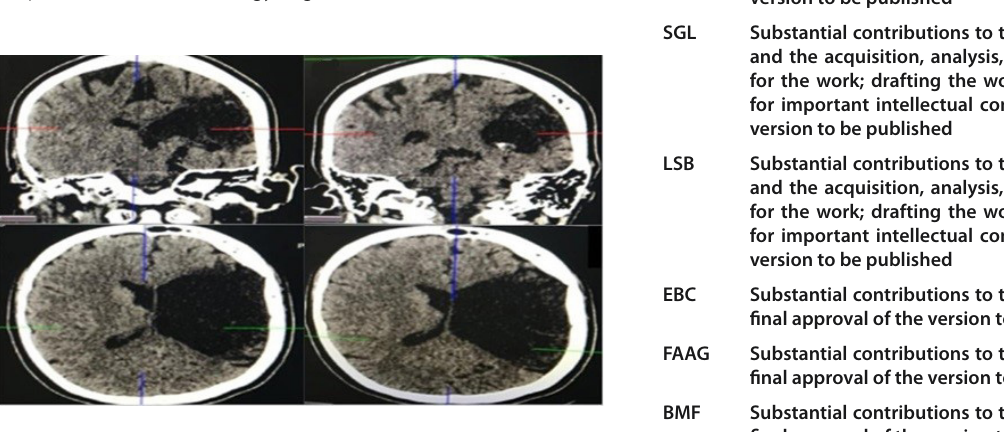
Fig. 5 - Cranial computed tomography scan with lesions suggestive of chronic ischemia in the left parietal, temporal and frontal